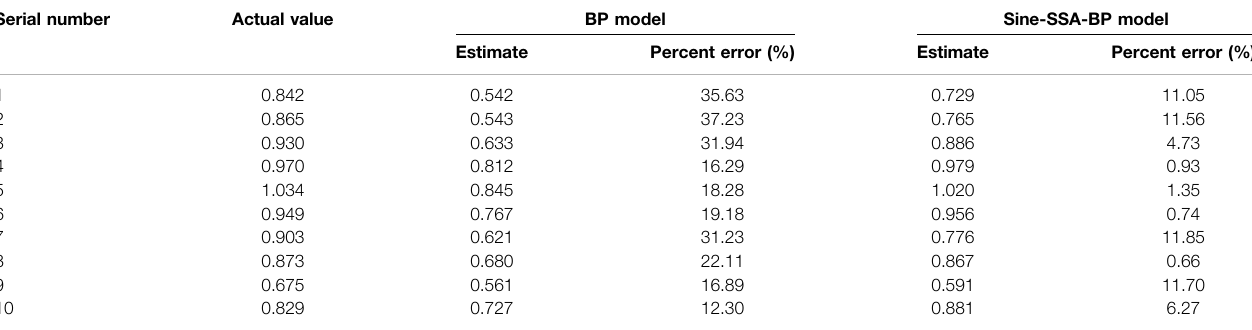
TABLE 4 | Prediction results for water injection.